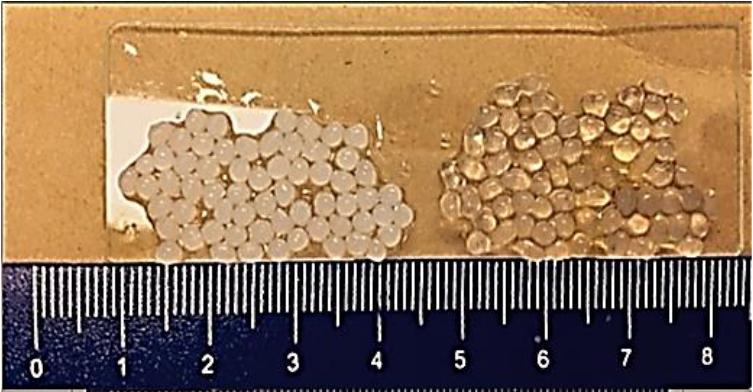
Figure 7. Alginate pellets with 2 mm in diameter ( left ) comprised of indomethacin-loaded S100 nanoparticles and alginate pellets ( right ) incorporating indomethacin powder developed using the drop technique [86], reproduced with permission from Wiley.